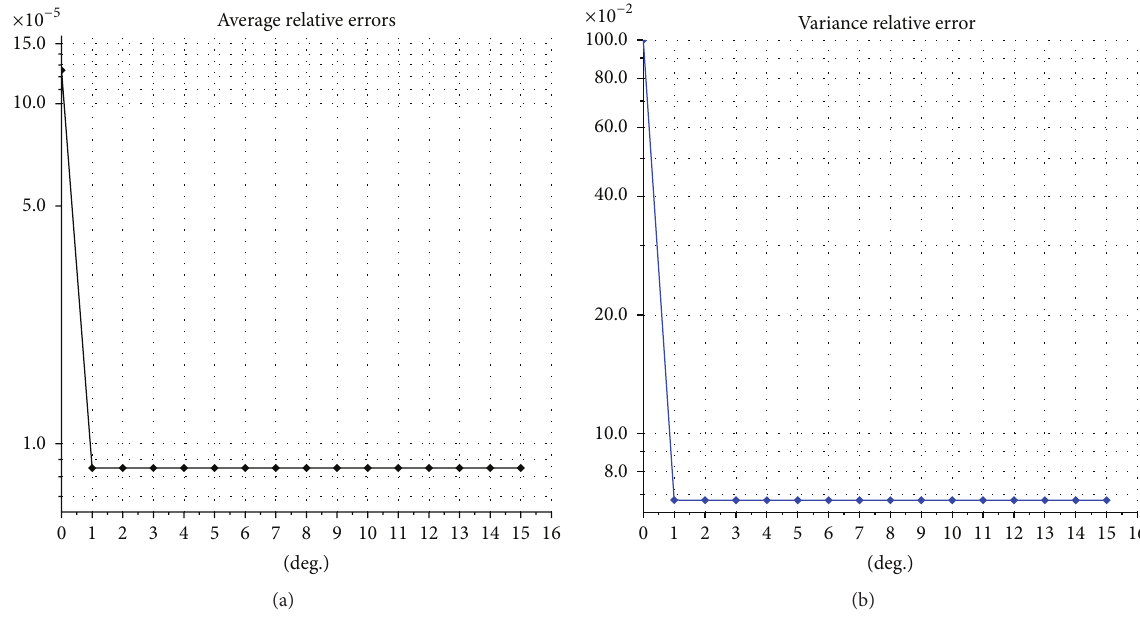
Figure 14: Semilogy scale plot of the relative errors RE (𝑝) MEAN (a) and RE (𝑝) VAR (b) computed for 𝑝 = {0,1,2,...,15} , for the CIR interest rate model at time 𝑇 = 1 , with parameters 𝛼 = 0.1 , 𝛽 = 0.2 , 𝜎 = 0.15 , and 𝑅 0 = 110 .